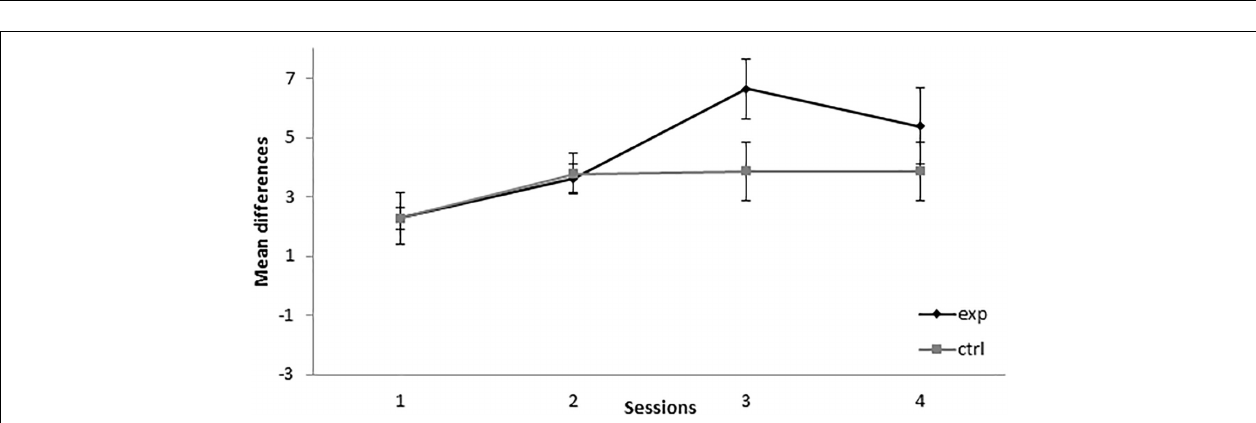
FIGURE 1 | Conditioning phase in Experiment 1. PreX-X differences ( ± SEM), averaged for the two X – presentations per session in conditioning, are displayed. The black line represents the group that was trained with 14 A+, two AX – , 12 F – , and two X – presentations per session in conditioning. The gray line represents the group that was trained with 14 A+, two BX, 12 F – , and two X – presentations per session.